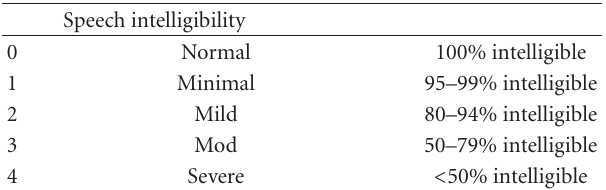
Table 3: Ranking of speech intelligibility.